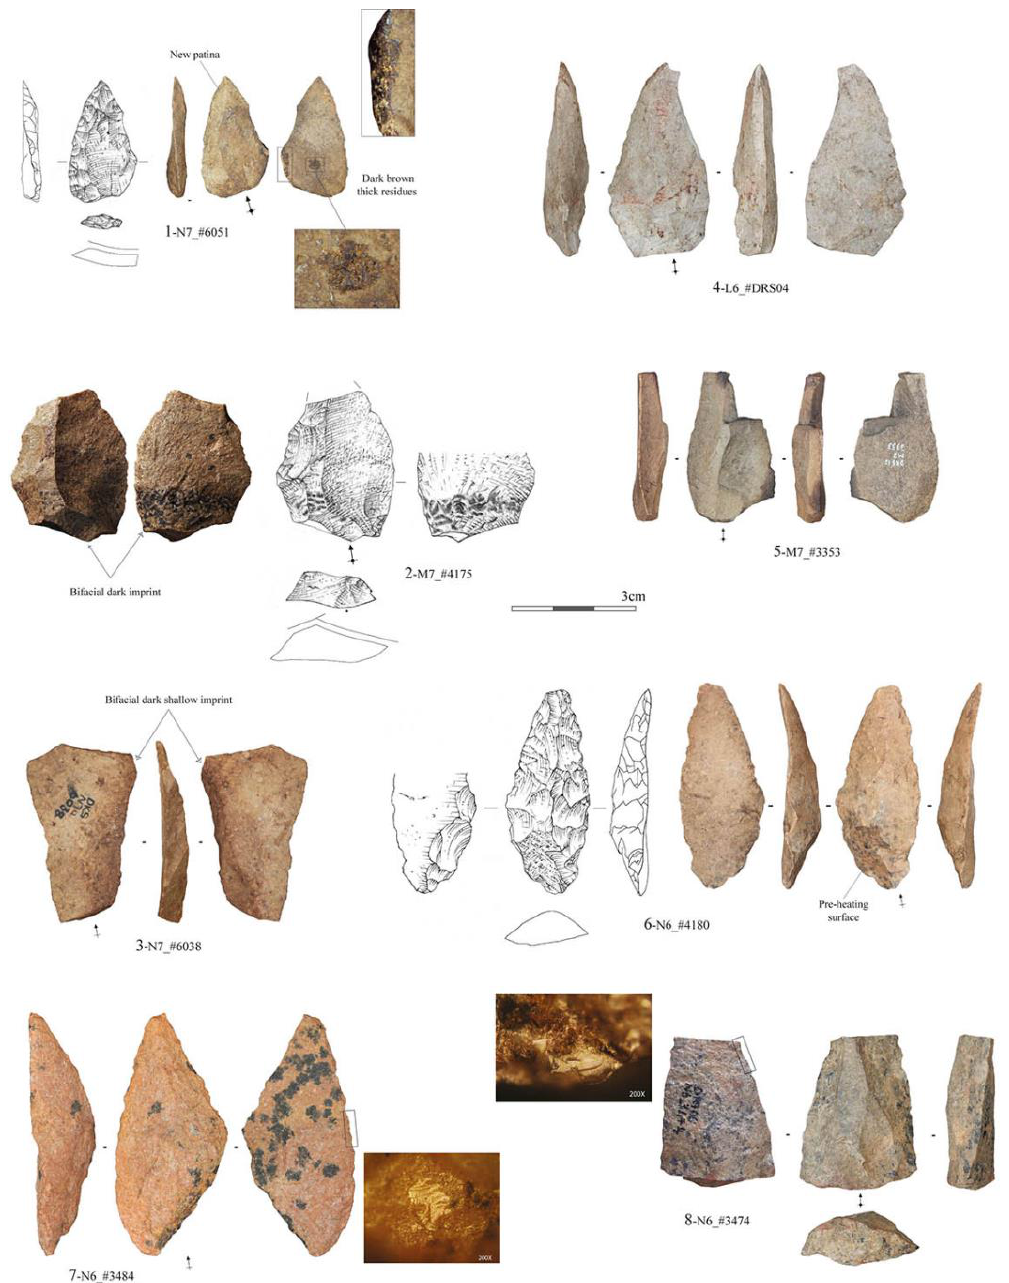
Figure 10 . Lithics from the stratigraphic unit Lynn at Diepkloof Rock Shelter with details on functional traces. N°1: unifacial point with macro-residues on its proximal/ventral surface and interpreted as possible adhesive; the retouch shows a recent patina. N°2: unifacial point with step terminating removals and pseudo-burination; the chronology of the removals indicates the fracture predates the retouch. N°3: unifacial point with a bifacial black imprint on its proximal part that is interpreted as possible adhesive. N°4: triangular flake with a bending initiated and step terminating fracture (additional example from square L6). N°5: blade with a lateral bifacial shallow imprint that is interpreted as possible adhesive. N°6: unifacial point with a bifacial proximal shaping and with a bending initiated step terminating removal on the dorsal surface. N°7: unifacial point with a bifacial proximal shaping and a polish related to wood cutting. The tool is crushed at its tip. N°8: triangular flake with a straight fracture and a polish related to wood cutting (Drawings Michel Grenet). A high resolution version of this figure is available at